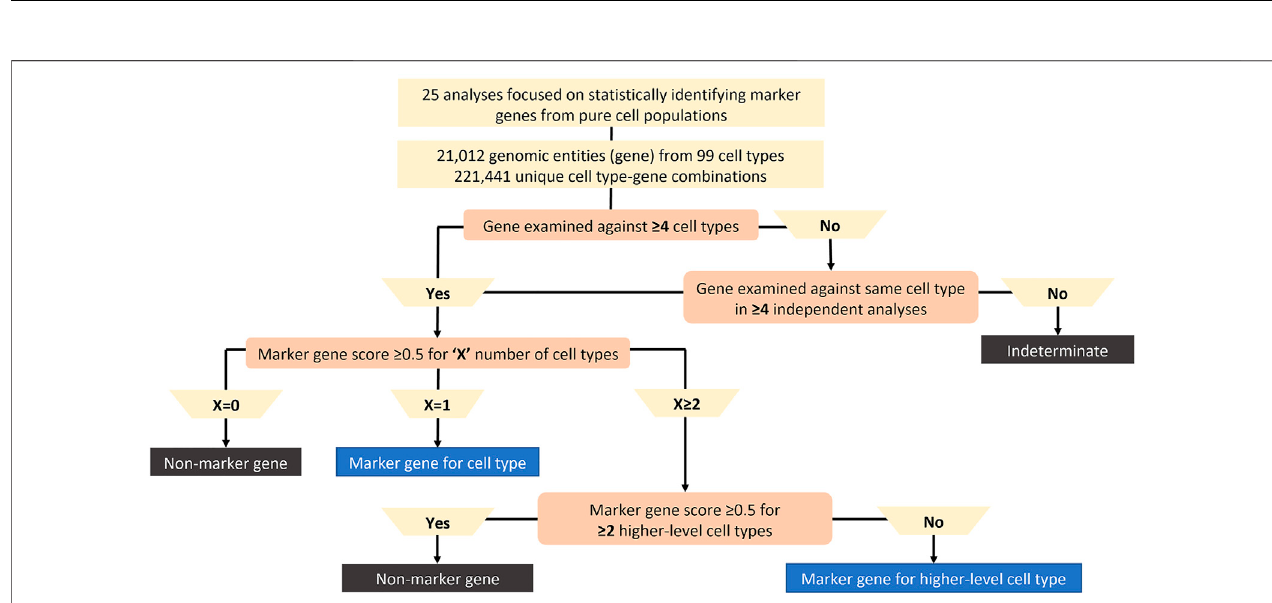
FIGURE 2 | Marker gene classi fi cation algorithm. The algorithm classi fi es genes with < 4 cell types as Indeterminate due to insuf fi cient data to analyze the gene unless the gene was examined against the same cell type in ≥ 4 separate analyses. Signi fi cant marker gene score (i.e., at least 0.5) for at least two-thirds of publications consideredforeachgene-celltypepair.Thenumberofsigni fi cantgene-celltypepairsperagivengeneis “ X ” .1)IfX (cid:1) 0,thegeneisnotamarkergeneforanycelltype,2) IfX (cid:1) 1,the geneisamarkergene forone celltype, 3) IfX ≥ 2, thenthe geneisamarker geneformore than onecell type. When X ≥ 2,if thegene ismarkergene for multiple cell types from the same higher-level cell type (ex: connective tissue cells), then the gene is amarker gene for the higher-level cell type. When X ≥ 2, if the gene is marker gene for multiple cell types from at least 2 higher-level cell types (ex: connective tissue cells and T cells), then the gene is a non-marker gene due to lack of speci fi city across publications.